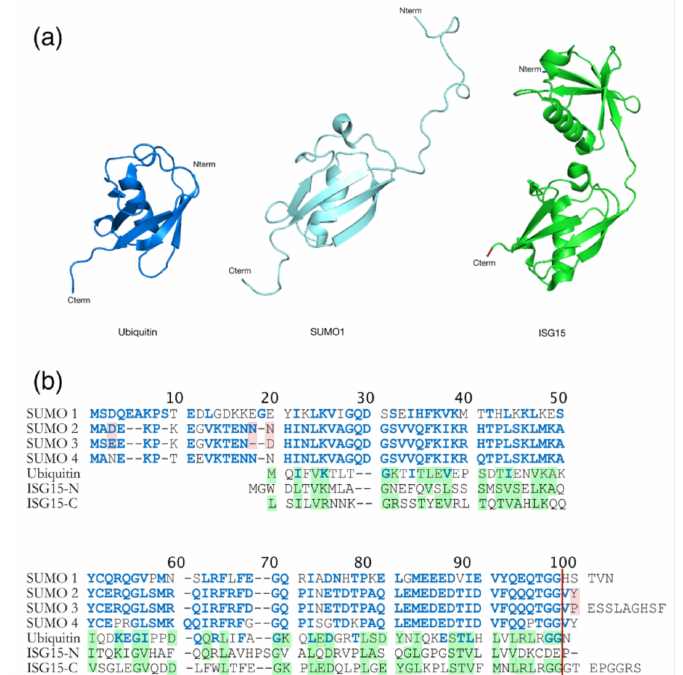
Figure 6. Comparison between Ub and Ub-like proteins: SUMO and ISG15. ( a ) Structural comparison between Ub (heavy blue, PDB: 1A5R), SUMO-1 (ligth blue, PDB: 2QHO), and ISG15 (green, PDB: 3PHX). They contain a typical ββαββαβ fold, even if SUMO-1 has long unstructured N-terminal domain which is absent in Ub. ISG15 is composed with two Ub-like domains in N- (TSG15N) and C- (TSG15C) terminus. ( b ) Amino acid sequence alignments of Ub, the four SUMO homologs and ISG15 from humans. Identities and similarities are indicated between Ub and SUMO (blue residues into Ub sequence) and between Ub and ISG15 (shaded green residues in Ub and ISG15). Differences between SUMO-2 and 3 are highlighted in pink. The red vertical line represents the GG end free after the maturation step required for sumoylation. The amino acid sequence homology between SUMO and Ub is 18% [152], and 30% between Ub and ISG15